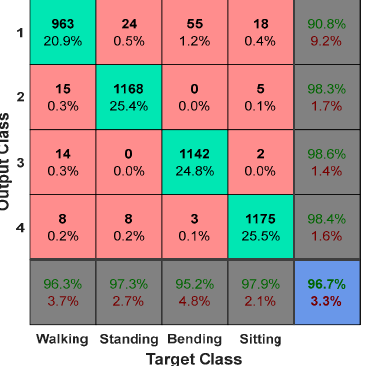
Figure 23. Confusion matrix for identified human activities.